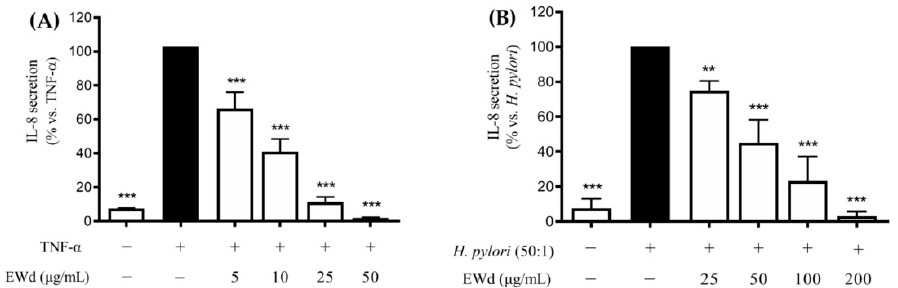
Figure 5. Effect of Rhus coriaria L. digested ethanol-water extract (EWd) on TNF- α ( A ) and H. pylori - induced IL-8 release in GES-1 cells ( B ). The release of IL-8 was assessed through an ELISA assay. EGCG 20 μ M ( − 74%) was used as reference compound (black color). Data are reported as percentage in comparison to the stimulated control, which was arbitrarily assigned to 100% value. ** p < 0.01, *** p < 0.001 versus TNF- α or H. pylori . EWd, EW extract subjected to in vitro simulated gastric digestion.